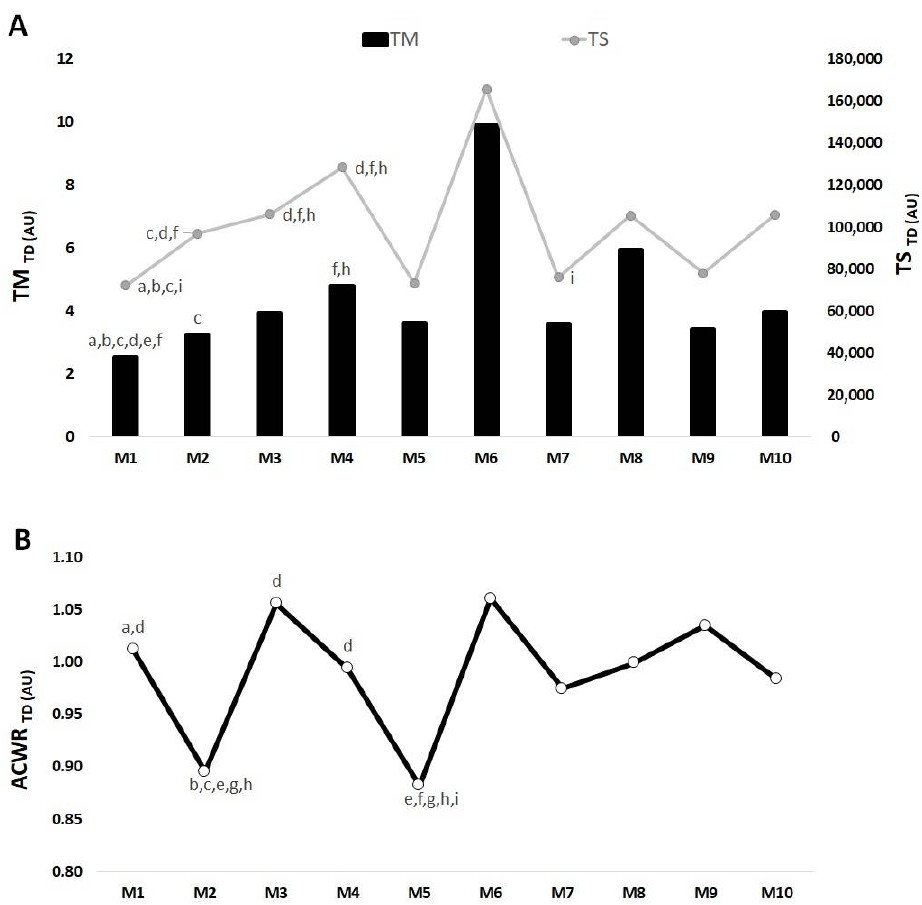
Figure 5. TM, TS ( A ) and ACWR ( B ) variations calculated through the total distance across 10 mesocycles for the whole team. M: mesocycle; a: difference from M2; b: difference from M3; c: difference from M4; d: difference from M5; e: difference from M6; f: difference from M7; g: difference from M8; h: difference from M9; i: difference from M10.